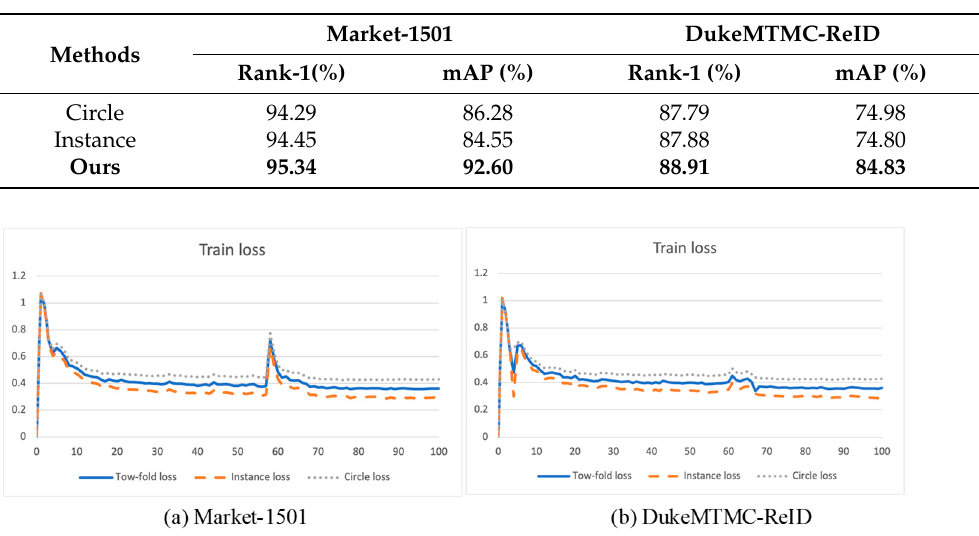
Table 4. The effectiveness of loss selections on TL-TransNet.